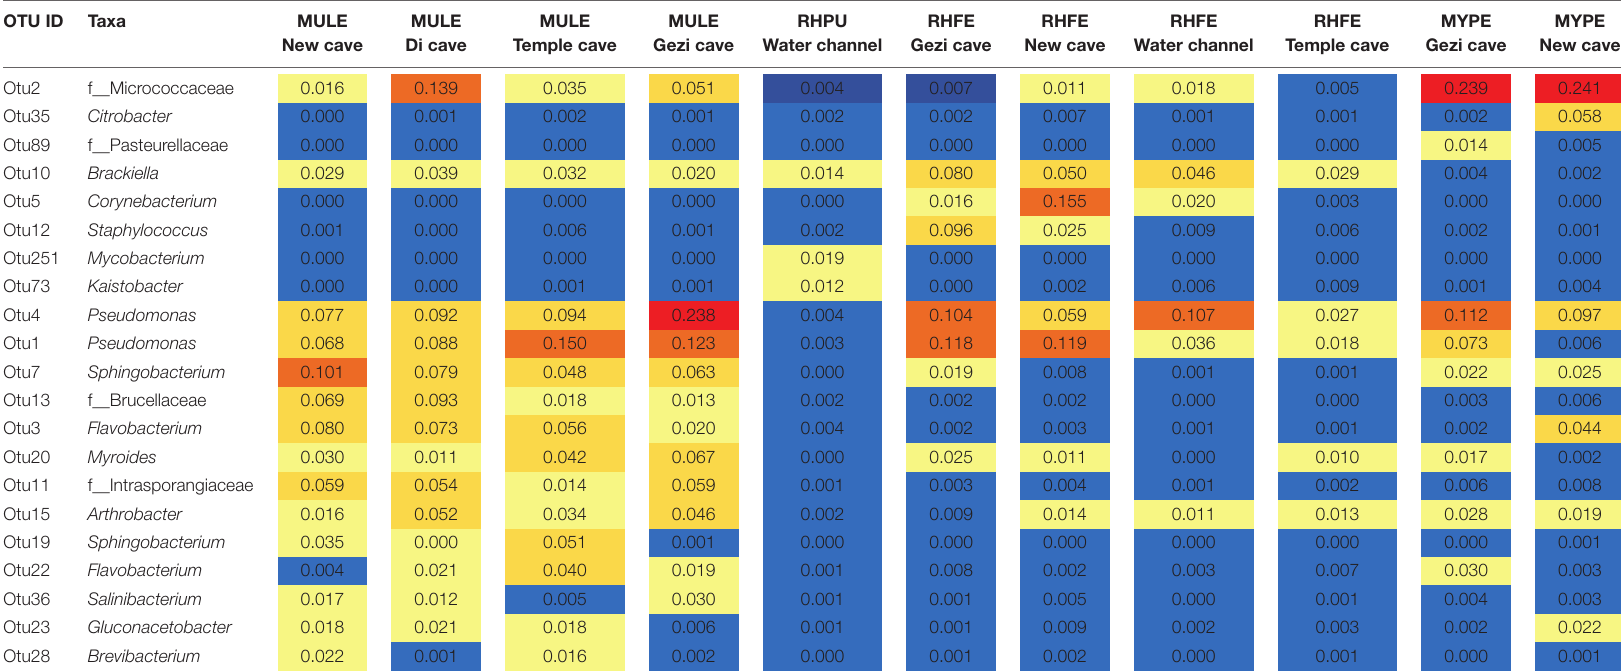
TABLE 2 | Heatmap of the average relative abundance ( > 1%) of bacterial Operational Taxonomic Units (OTUs) that were differentially abundant among bat species sampled from different localities. OTU ID